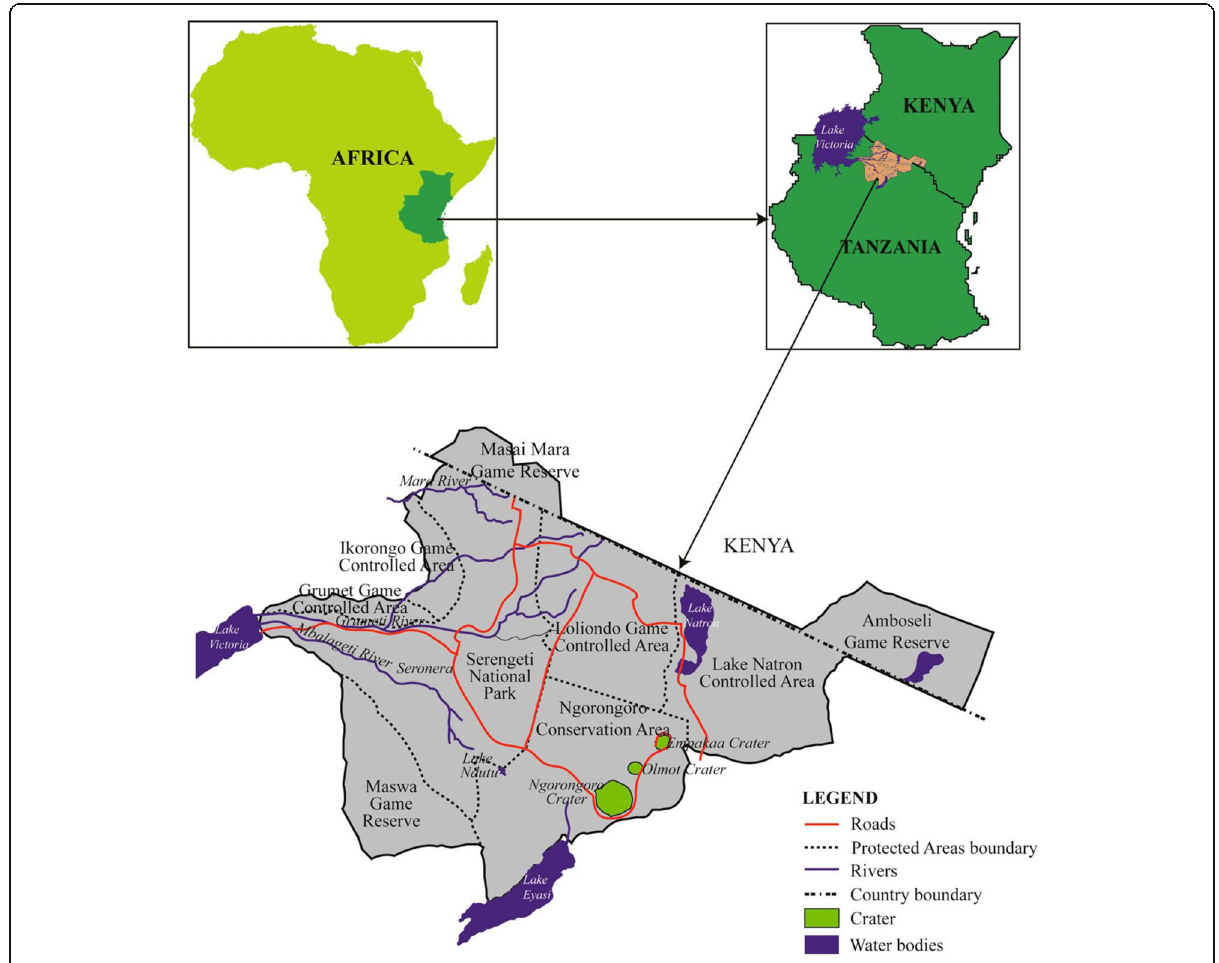
Fig. 1 A map of the study area showing the Serengeti ecosystem